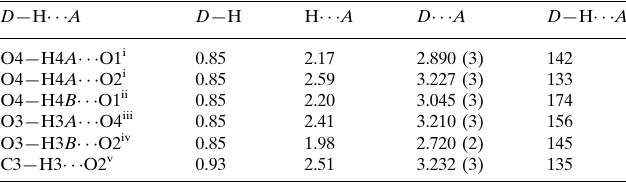
Hydrogen-bond geometry (A˚ , (cid:2)